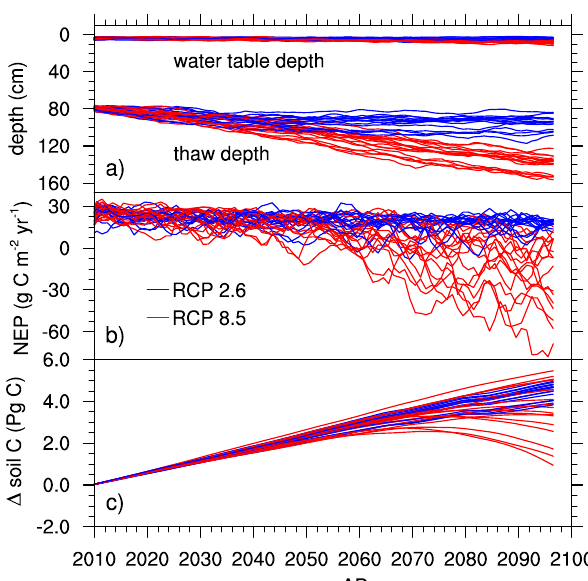
Fig. 10. Results of 31 LPX simulations forced by CMIP5 model outputs using scenarios RCP 2.6 (blue) and RCP 8.5 (red) for the period 2010–2100AD as described in Stocker et al. (2013). Plots show that (a) peatland water table depth and thaw depth increase over time, (b) peatland NEP and (c) soil C start to decrease around 2050AD in some simulations using RCP 8.5. Plots show the 5yr running average of model